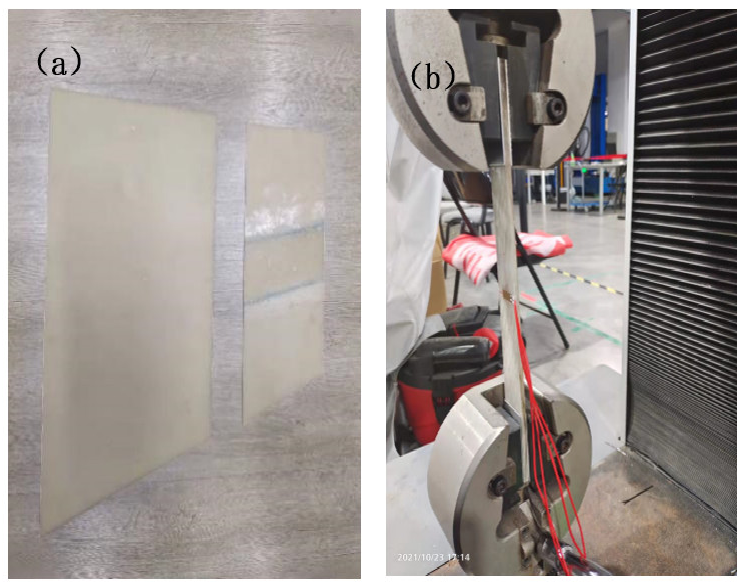
Figure 2. Core board lay-up parameters: ( a ) inner and outer wing core board; ( b ) tensile test.